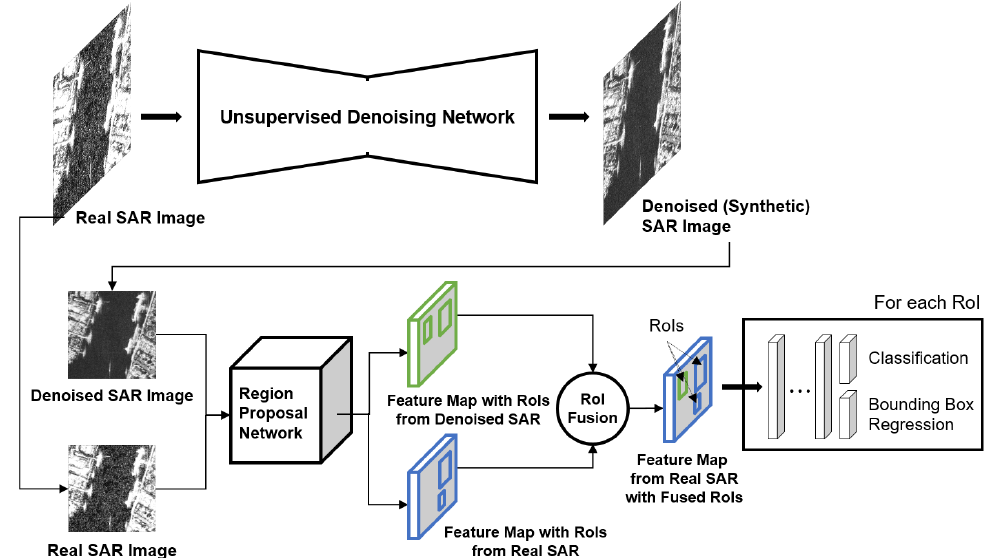
Figure 6. Overview of the proposed object detection framework: (1) connecting an unsupervised denoising network to an object detection network for dynamically extracting a denoised SAR image from a given noisy SAR image, and (2) forwarding an image pair of two SAR images to an object detection network and fusing region proposals from the two SAR images for complementarily integrating regional information.